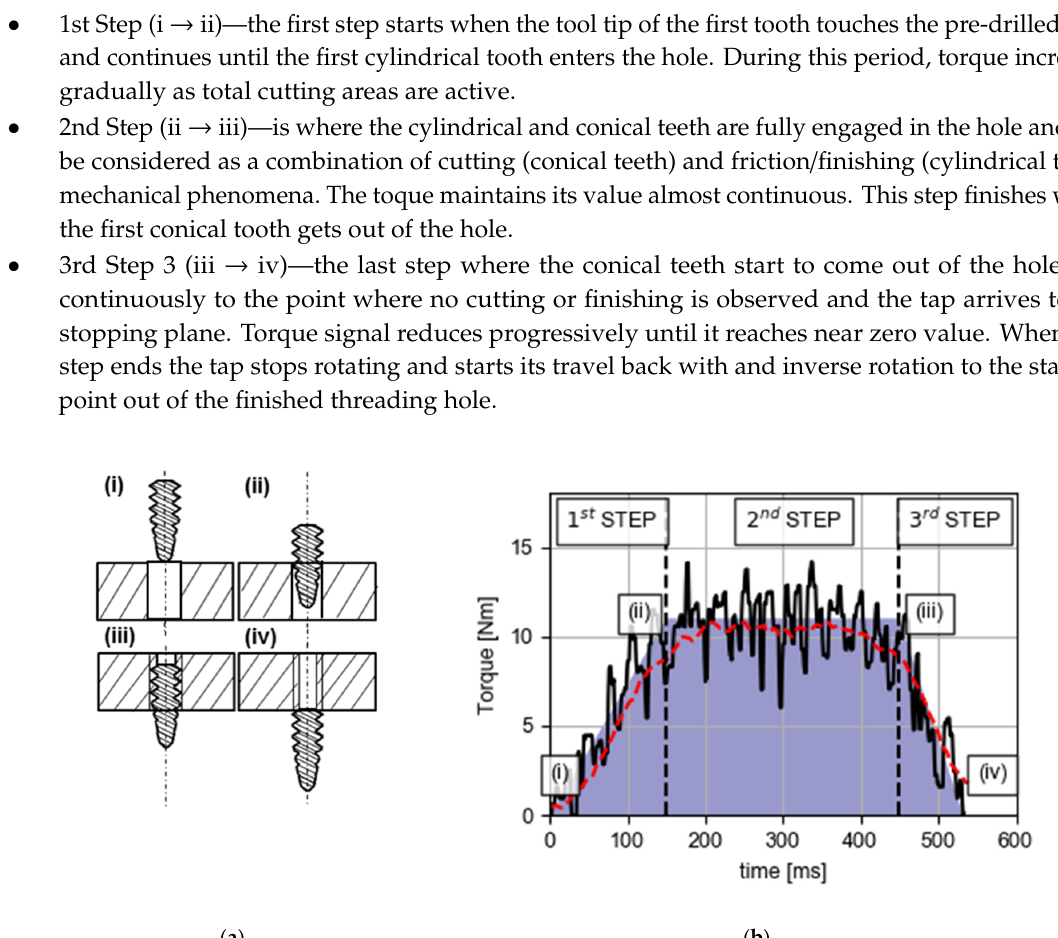
TAPPING ) to characterize